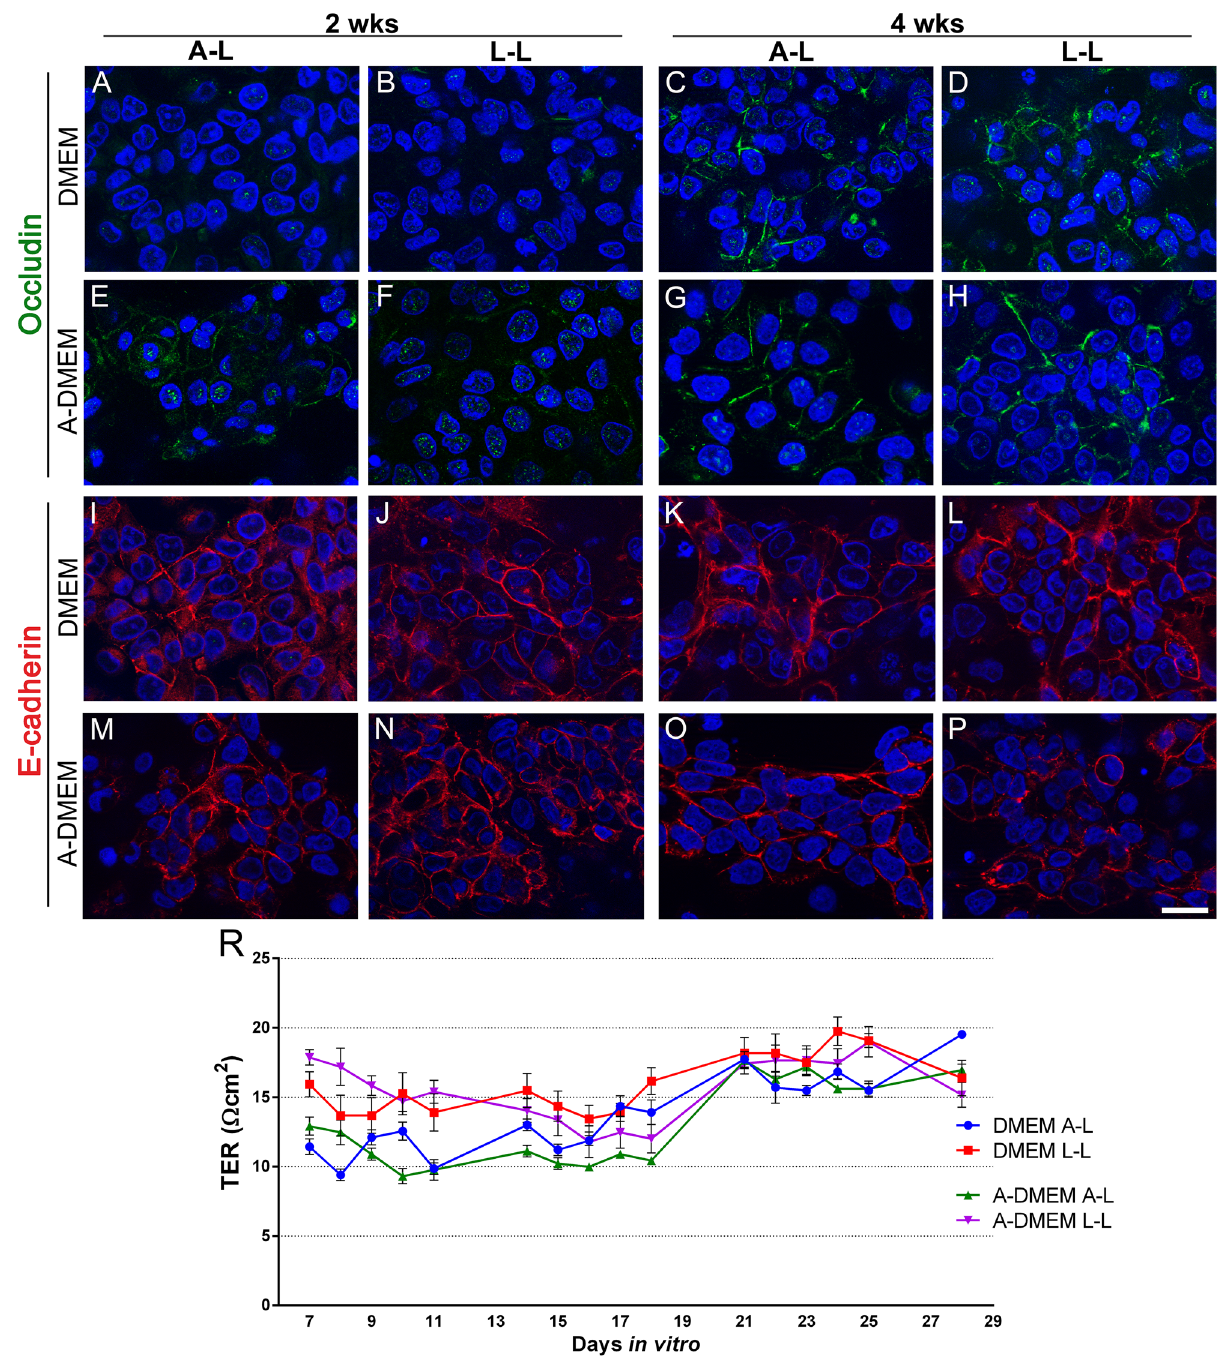
Figure 7. Occludin and E-cadherin expression and TER measurements in FLO-1 models. The cells grew on porous membranes in DMEM or A-DMEM culture media at the A–L and L–L interfaces for 2 or 4 wks. ( A – P ) Immunofluorescence labelling of occludin ( A – H ) and E-cadherin ( I – P ). Nuclei are stained blue. Occludin expression is higher in FLO-1 cells maintained in culture for 4 wks compared to 2 wks and when maintained in A-DMEM medium. All FLO-1 models exhibited E-cadherin immunoreactivity. Scale bar, 20 µm. (R) TER of different FLO-1 models at the A–L or L–L interface. The TER measurements started when the cells reached confluence (i.e., 7 days after the seeding). TER was then measured for another 3 wks (i.e., until the 28th day in vitro). FLO-1 models at the L–L interface show higher TER than at the A–L interface, except on the last day of measurements. However, all FLO-1 models exhibit very low TER. TER was measured in 4 independent cell cultures per